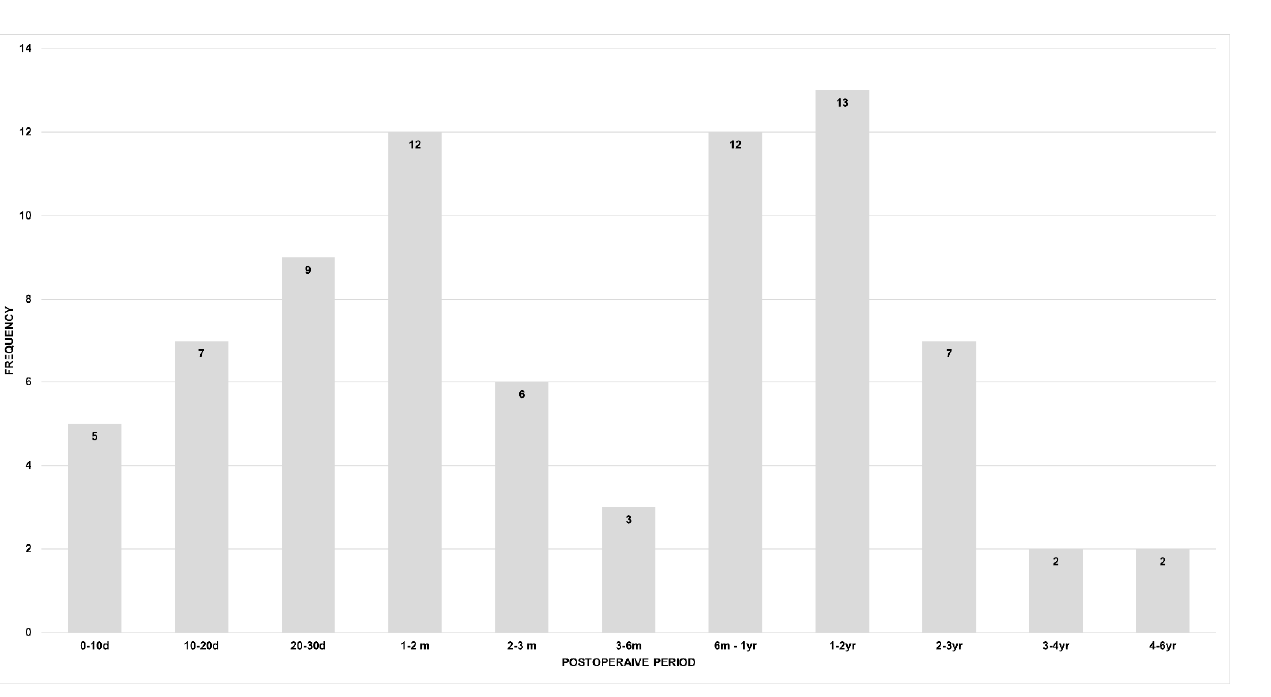
Figure 1. Frequency of postoperative recurrence (d: day; m: month; yr: year). Patients in the two groups were followed up for a similar period (mean follow-up duration: ER, 30.1 ± 36.3 months; LR, 37.3 ± 29.1 months; p = 0.372). There were no statis-